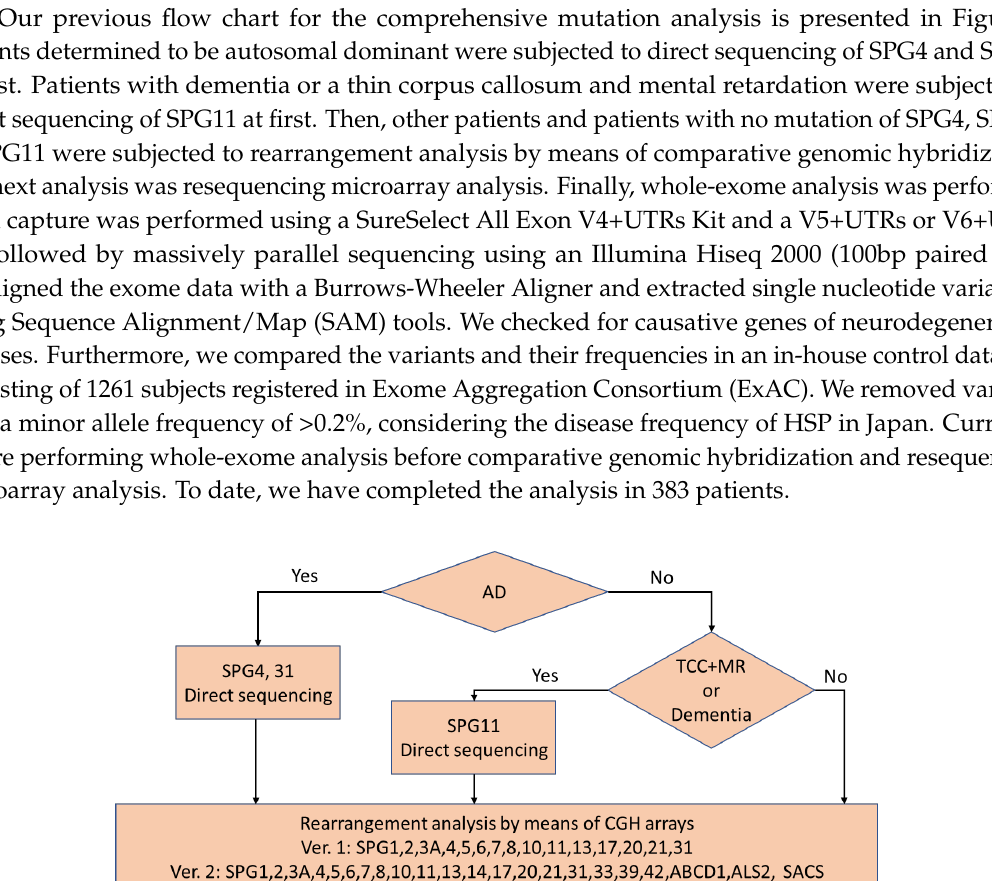
Table 1. Hereditary spastic paraplegia (HSP) genes found by the Japan Spastic Paraplegia Research Consortium (JASPAC).